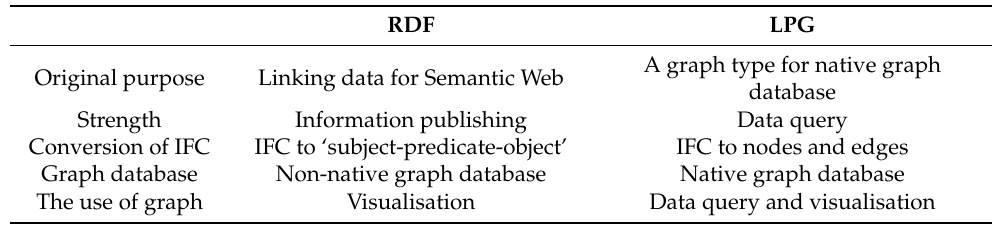
Table 3. Summary for RDF and